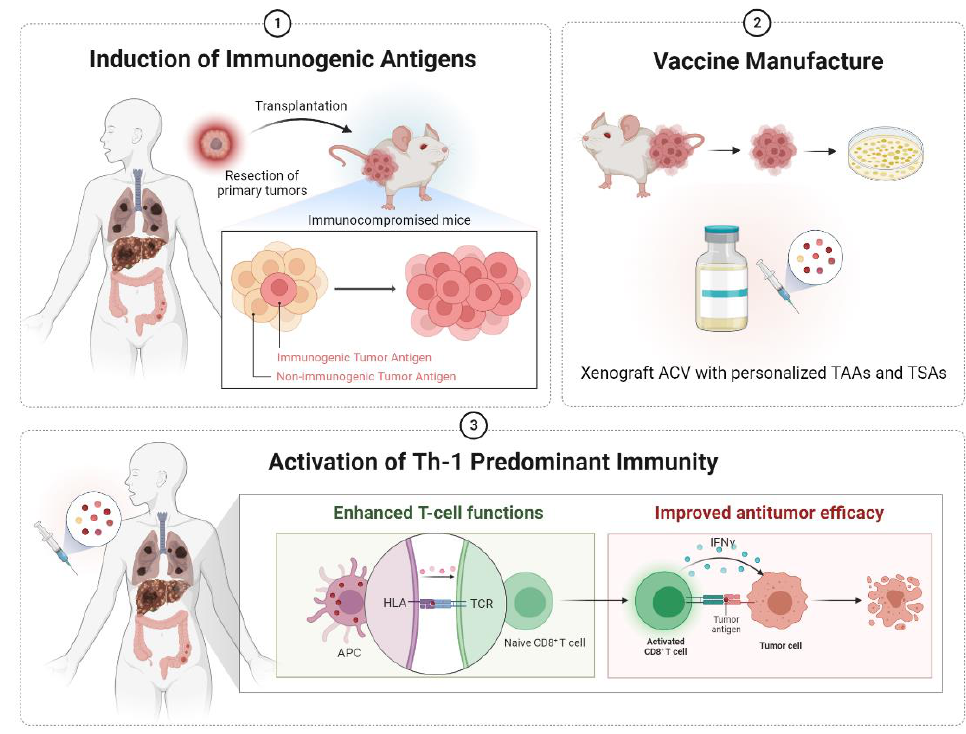
Figure 4. Diagrams illustrating the hypothesis in the current study. Tumors developed in a defective immune environment trigger the overexpression of immunogenic antigens. Based on this theory, we hoped to inoculate a few primary tumors from clinical cancer patients into immunocompromised mice. Then, the tumors progressively developed with the generation of personalized tumor antigens. The tumors were harvested and manufactured into xenograft ACVs. With the xenograft cancer vaccination, the APCs could recognize the unique tumor antigens and educate the naïve CD8 + T cells. The activated (educated) CD8 + T cells exerted cytolytic effects by releasing cytokines, such as IFN- γ. ACV, autologous cancer vaccine; APC, antigen-presenting cells; HLA, human leukocyte antigen; IFN- γ, interferon-gamma; TAAs, tumor-associated antigens; TCR, T-cell receptor; TSAs, tumor-specific antigens.